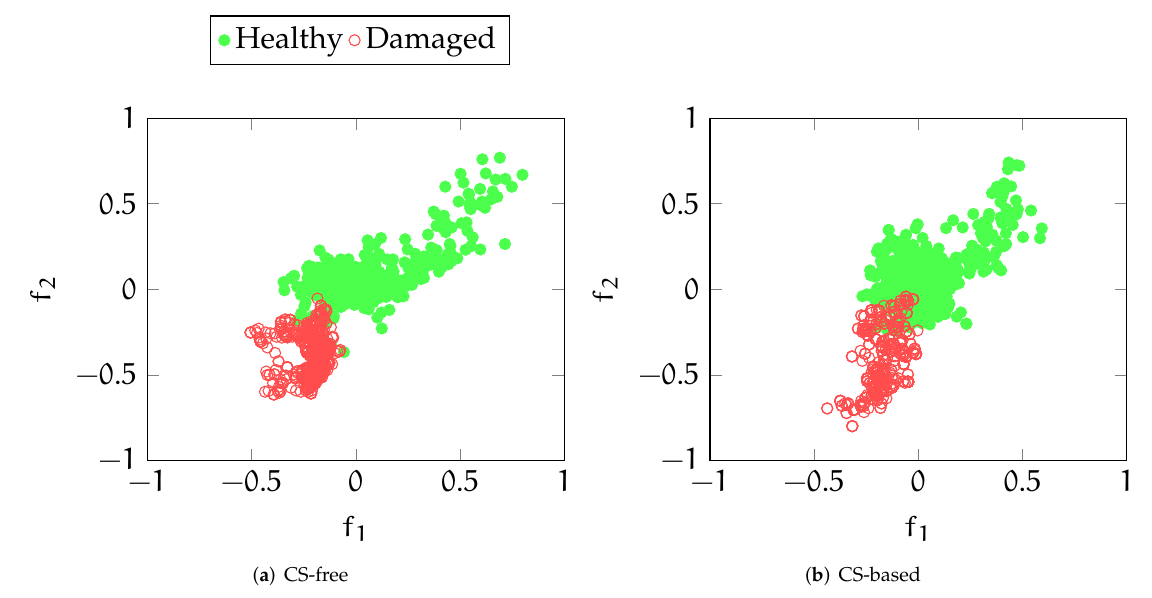
Figure 8. Feature space distribution with compression-free ( a ) and CS-processed ( b ) processing framework. Red points distributed in the south-west part of the feature space are referred to the damaged state, while the green ones represent healthy structural configurations.